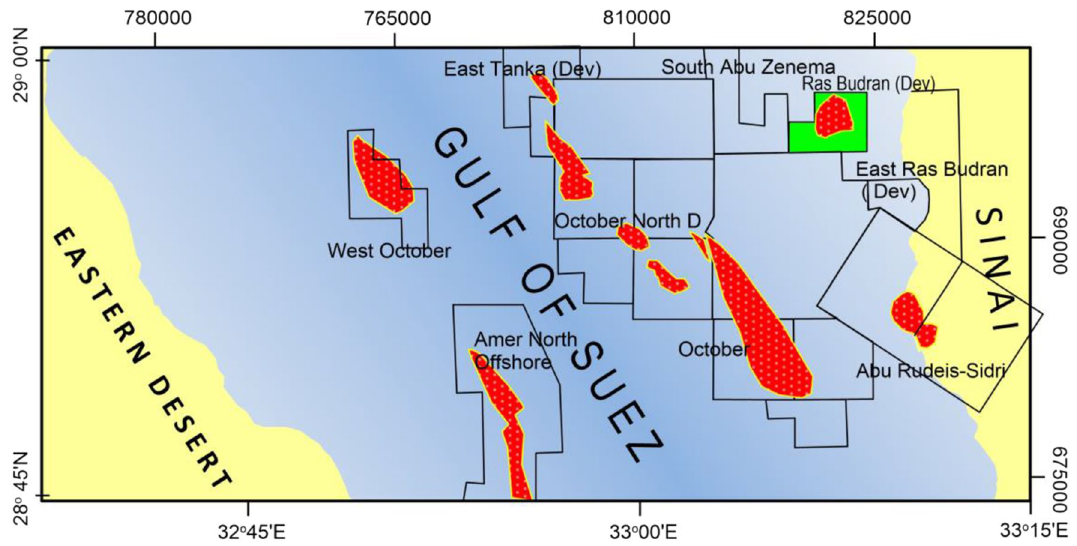
Fig. 1 Location map of the study area showing the major oil